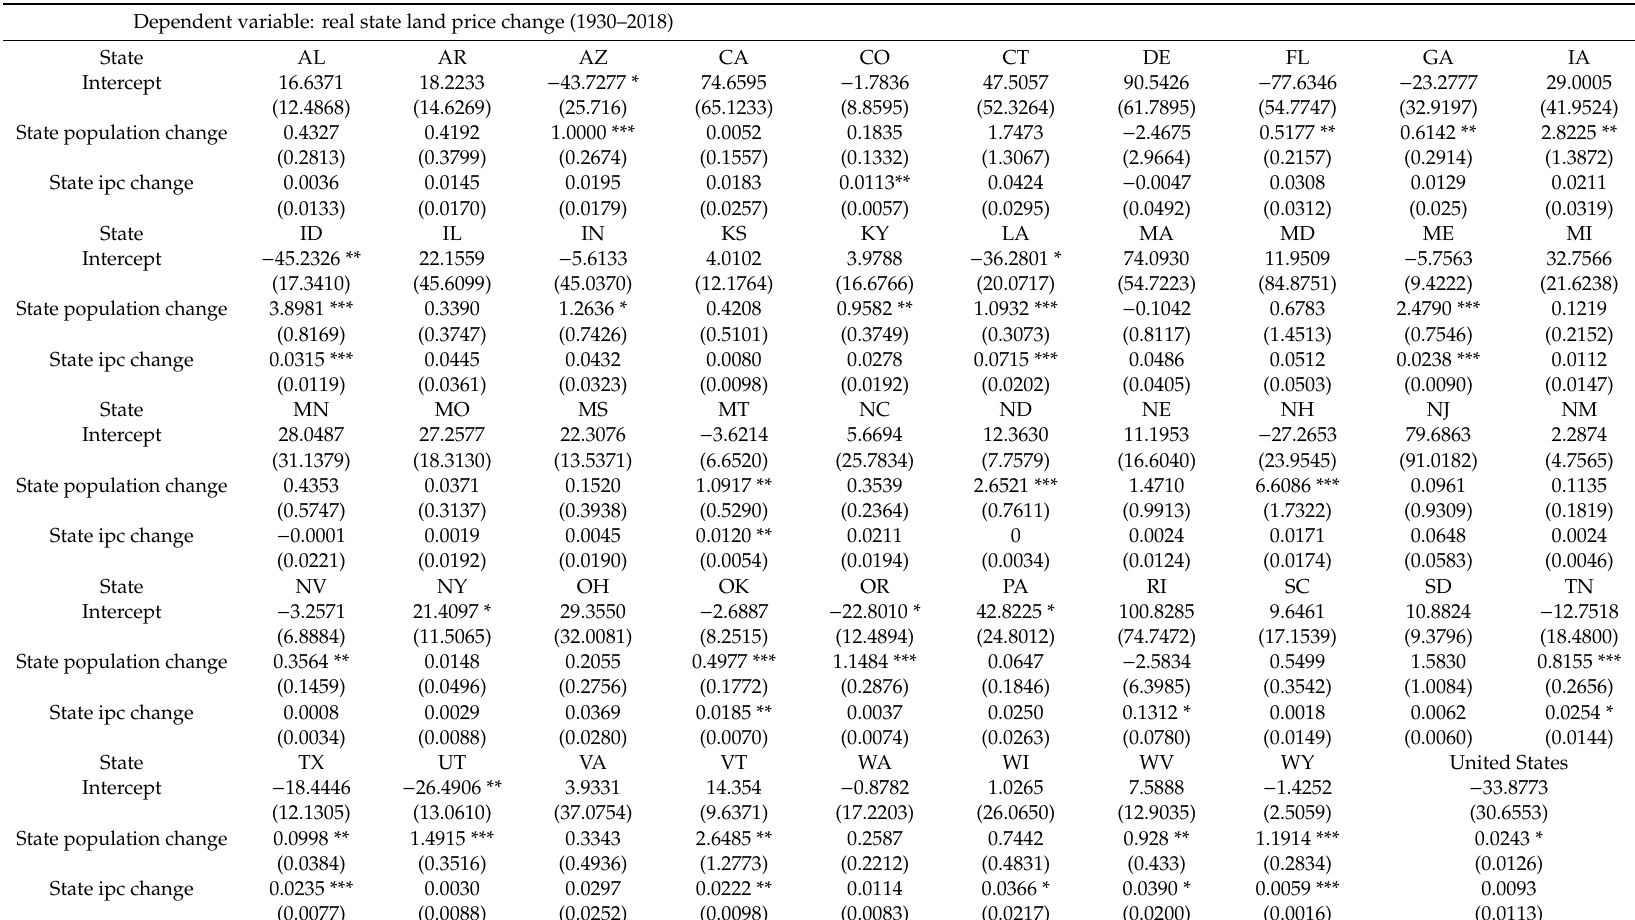
Table 3. The impact of state level population growth and income per capita growth on agriculture land price growth, real variables. Dependent variable: real state land price change